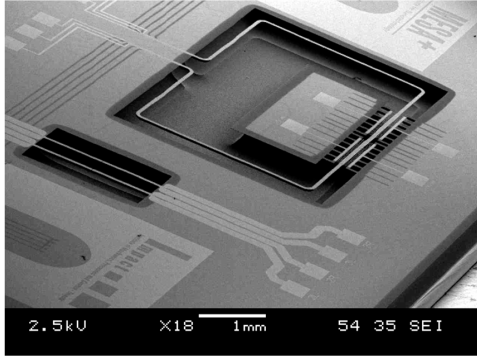
Figure 4. Fabricated system, showing the thermal ( left ) and Coriolis ( right ) flow